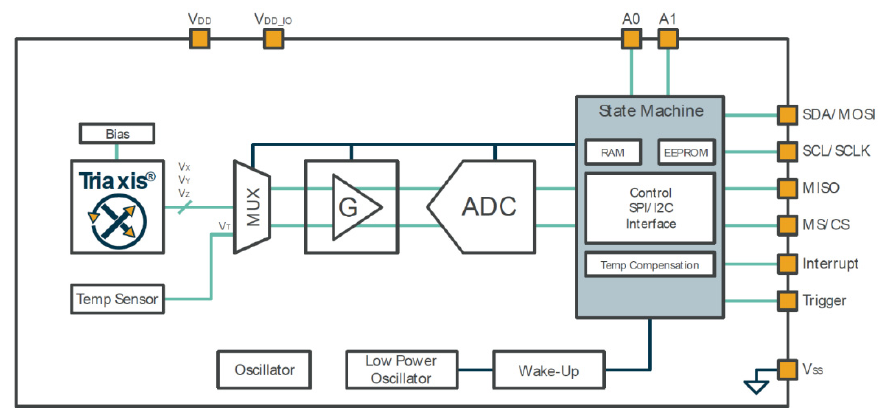
Figure 3. General block diagram of MLX90393 integrated circuit sensor.